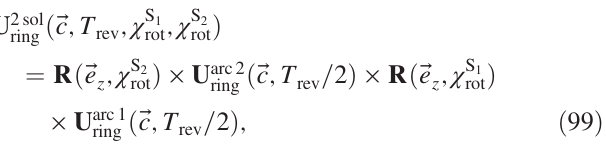
from Eq. (17), and the blue line denotes the s ⃗ S 0 is not in the ring ( xz ) plane